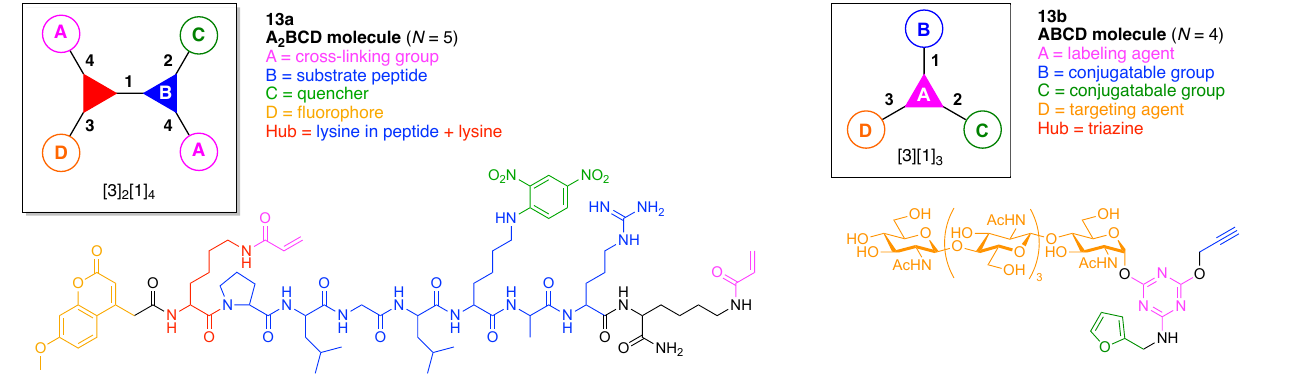
Figure 62. Two examples of enzymatically recognized hubs.